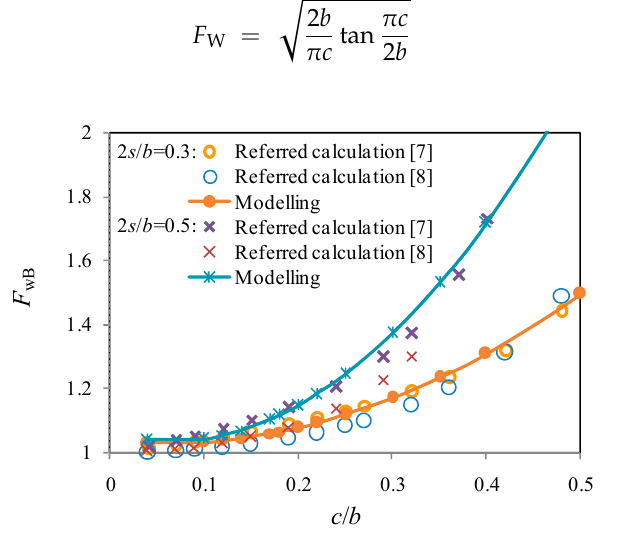
Figure 8. Off-central crack in tension clamp. Figure 8. O ff -central crack in tension